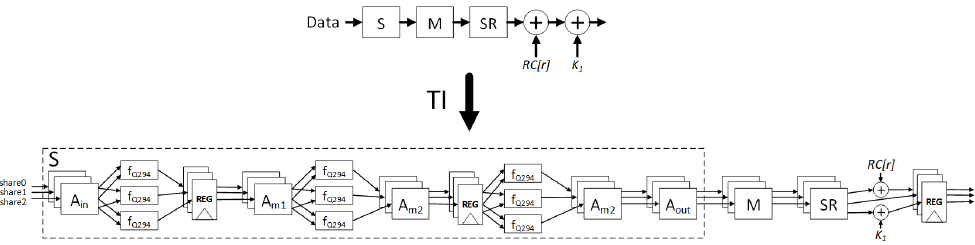
Figure 8. TI for decomposing S-box of